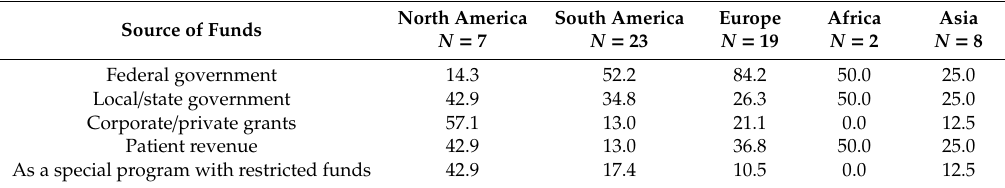
Table 4. Funding of the geriatric undergraduate programs ( N =